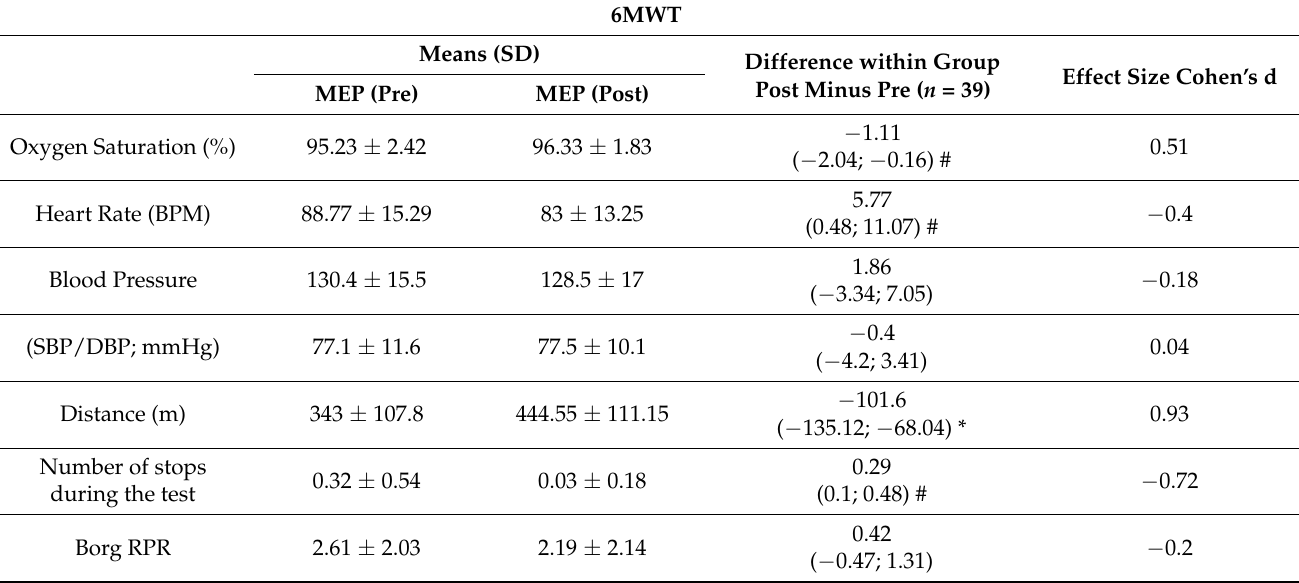
Table 3. Adjusted means (SD) for outcome at all study visits and mean (SD) difference within group and effect